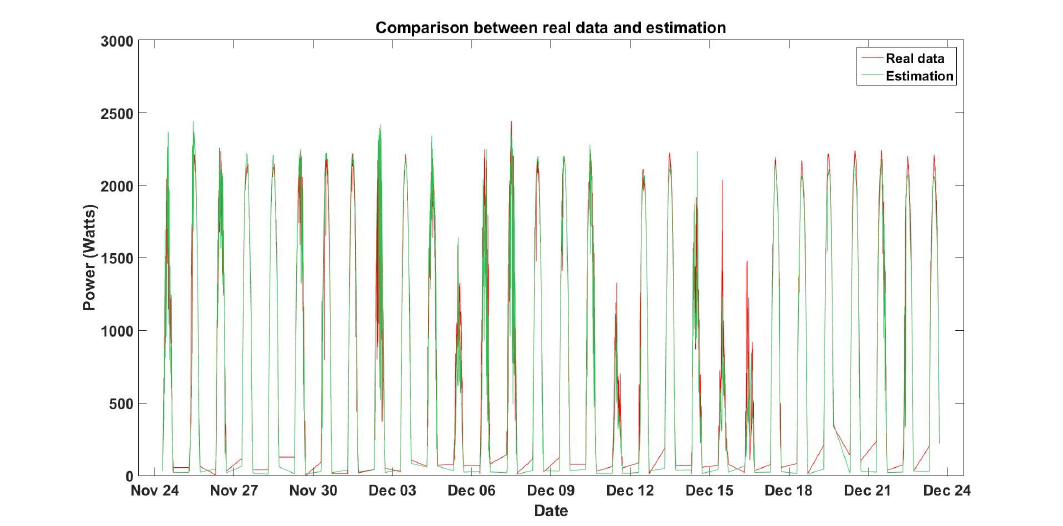
Figure 9. ANFIS results from HS.